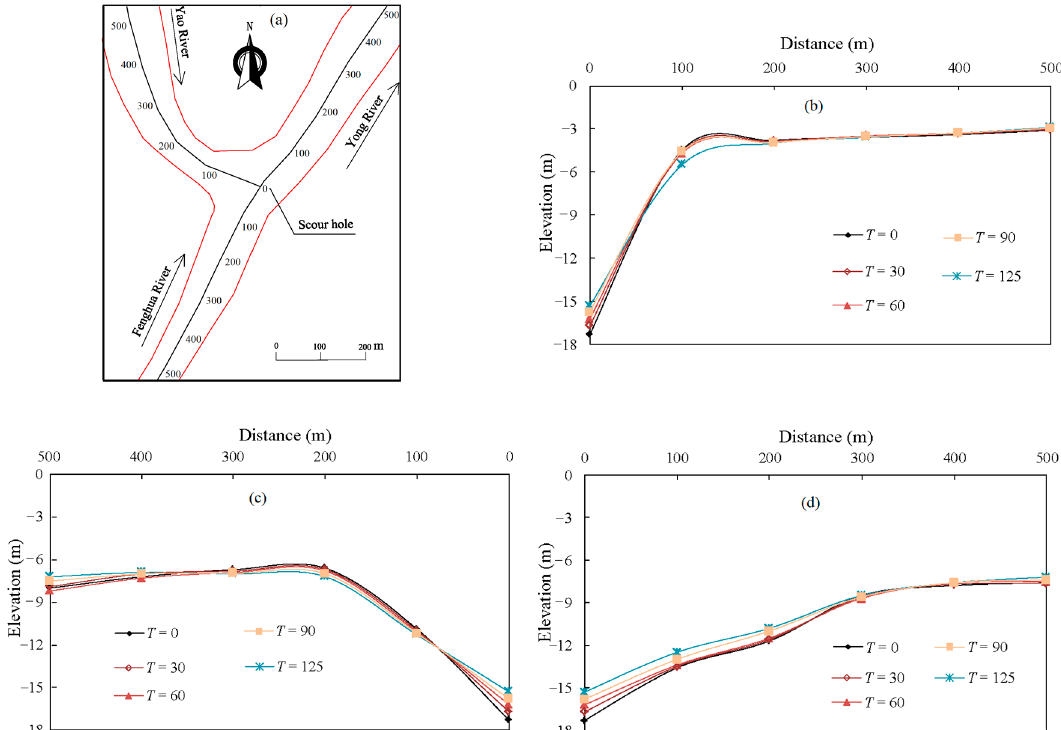
Figure 20. Longitudinal bed-level changes in the confluence: ( a ) Distance along the river centerline (accounted from the lowest scour position); ( b ) Along the Yao River; ( c ) Along the Fenghua River; ( d ) Along the Yong River.